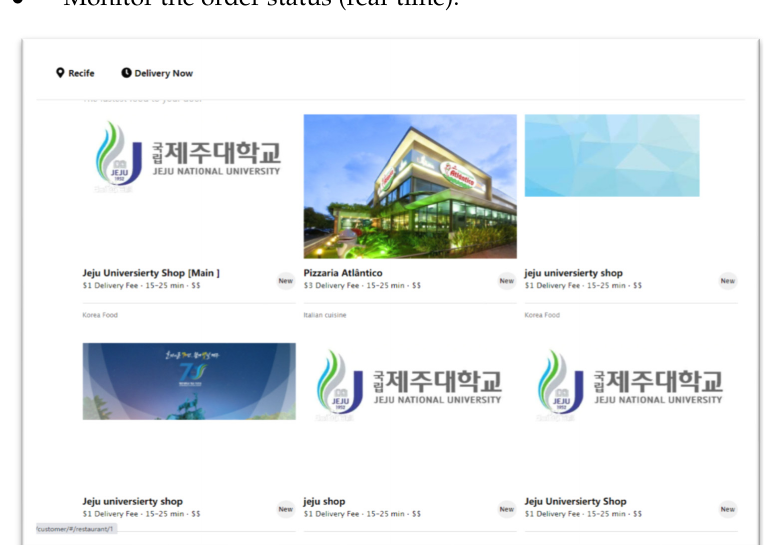
Figure 39. Client demo part in DAPP (Restaurant